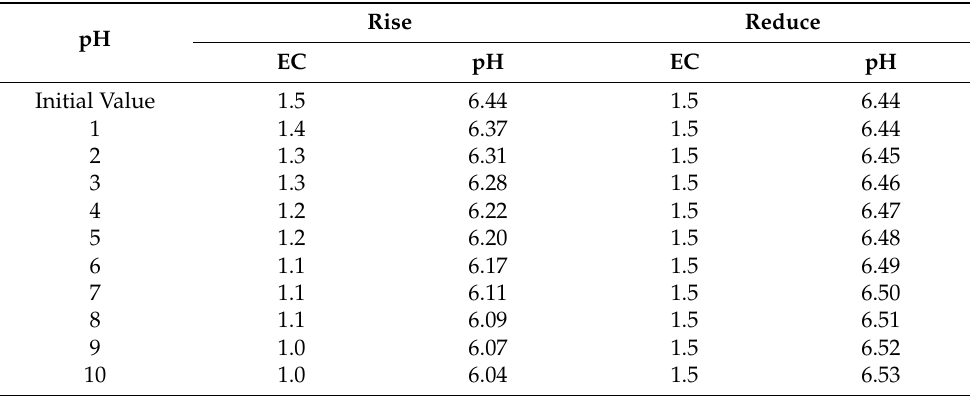
Table 7. Simulated pH rise and reduction